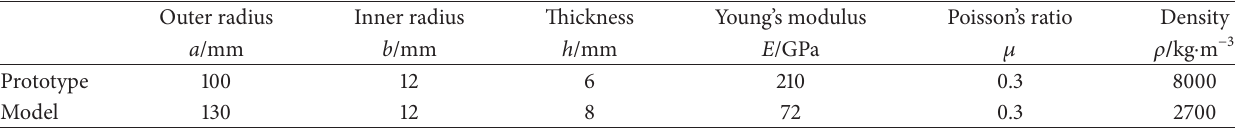
Table 7: Parameters of experimental plates.